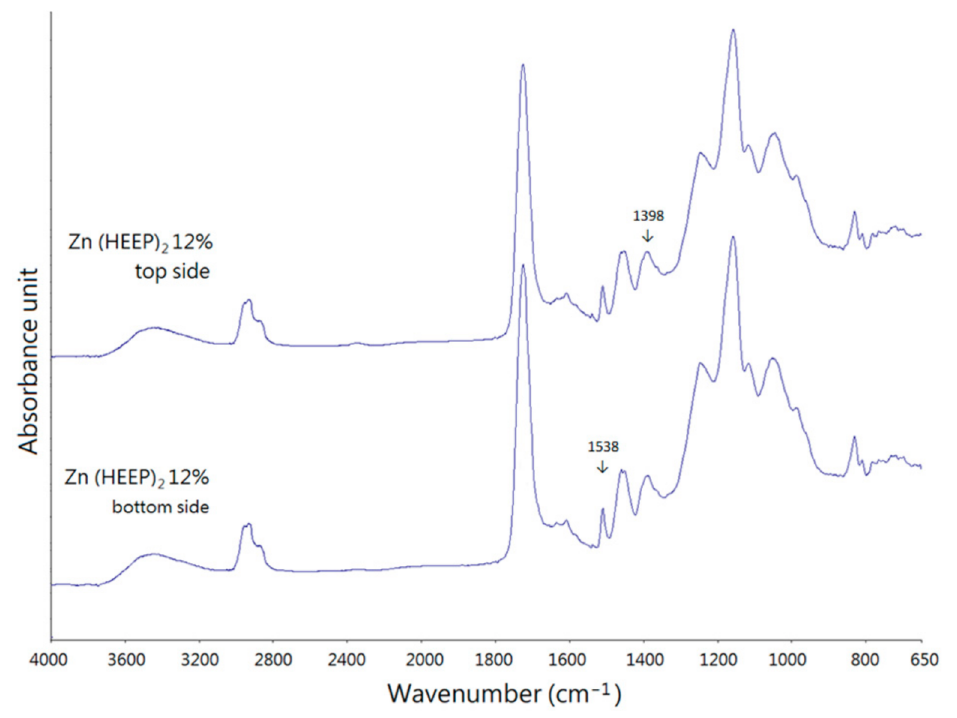
Figure 4. The ATR-FTIR analysis of the free UV film with 12 phr Zn(HEEP) 2 addition: top side, and bottom